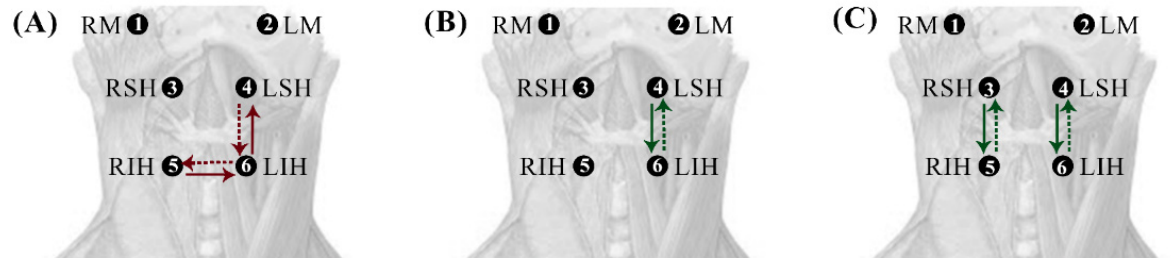
Figure 7. Diagrams with statistically significant differences in the cG-causality of the directionality of interaction pairs (asymmetry) for saliva ( A ), water ( B ), and yoghurt ( C ). Green and red arrows show healthy and dysphagic subjects, respectively. The continuous lines show the dominant direction.